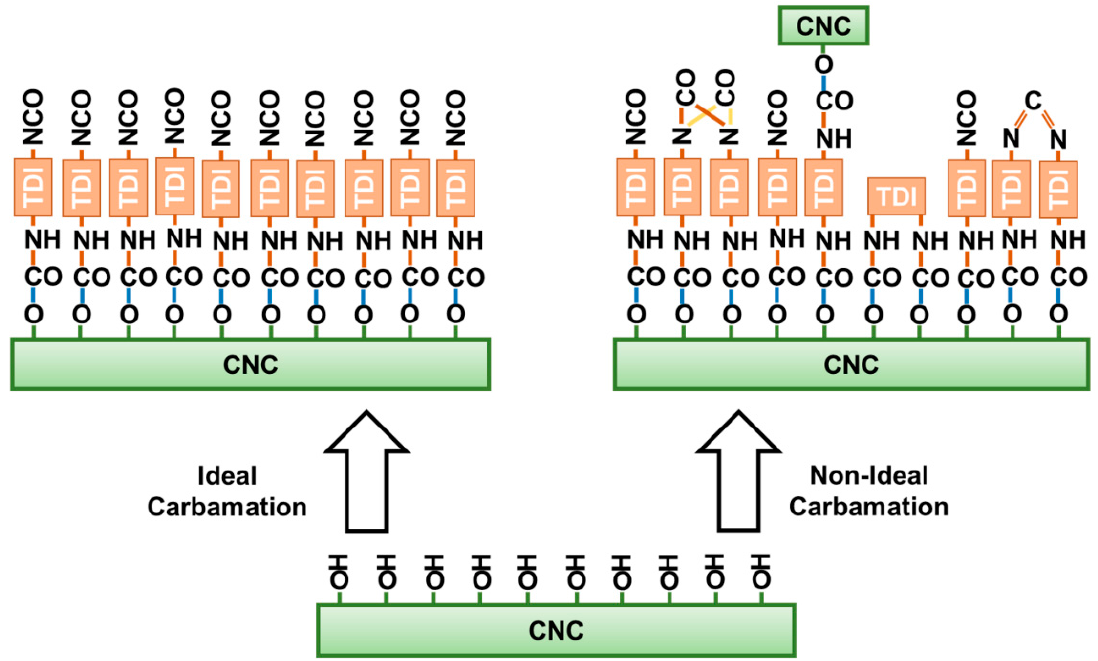
Figure 7. Possible side reactions of the isocyanates of TDI during CNC carbamation.